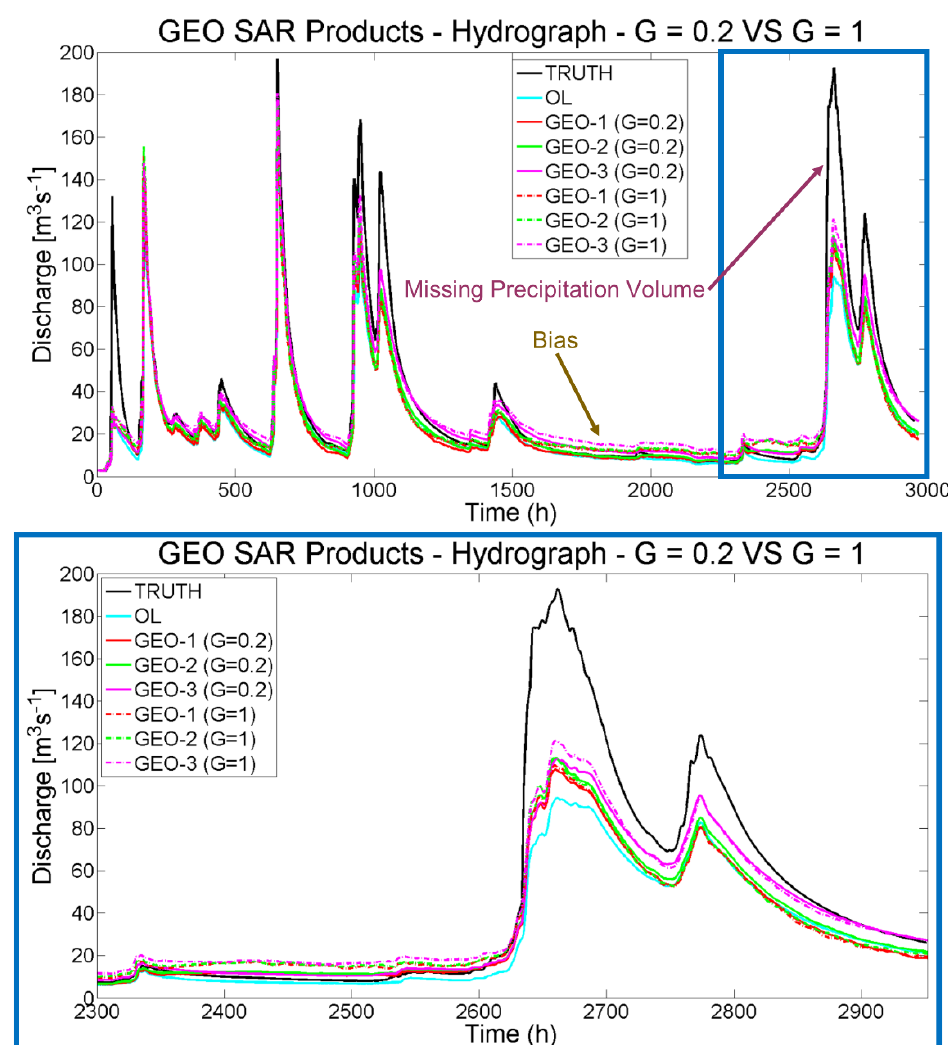
Figure 10. Comparison of discharge data generated by the OL run (i.e., G = 0) and the data generated by assimilating GEO SAR-like SM products with G values equal to 0.2 and 1. The figure also highlights: (i) the error produced by the missing precipitation volume (which originates an underestimation of the streamflow simulation with respect to that produced by the TRUTH run); (ii) the bias affecting the discharge obtained by the model after SM-DA with G = 1.